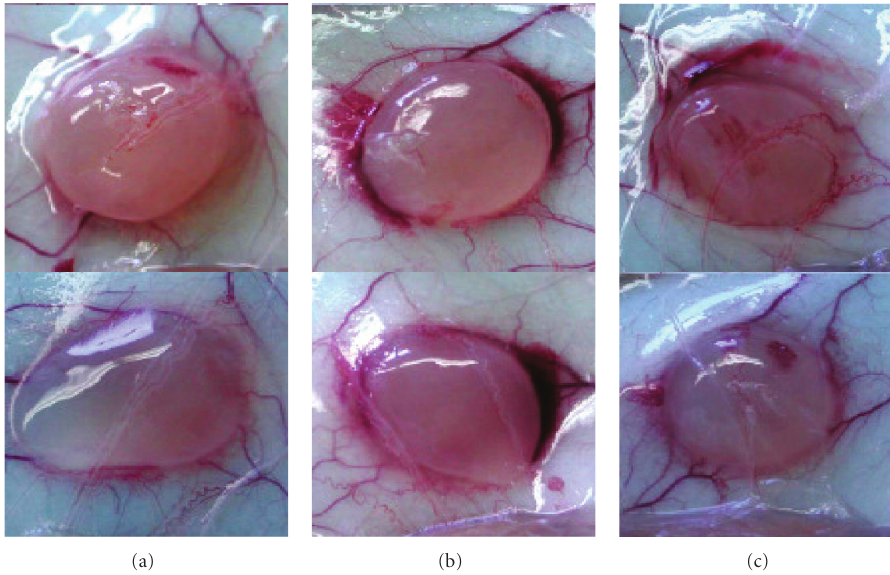
Figure 5: Tumor angiogenesis e ff ects microencapsulated HEK293 VEGF 165 b producing cells in experimental nude mice. Top and bottom reprentative sample of (a) Matrigel plugs with microcapsules containing HEK293 VEGF 165 b producing cells, (b) Matrigel plugs with microcapsules containing parental HEK293 cells, and (c) matrigel plugs with vehicle